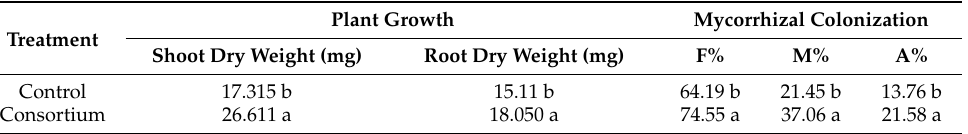
Table 1. Effect of bacterial inoculation on plant growth and mycorrhizal colonization (mycorrhizal frequency (F%), mycorrhizal intensity (M%) and richness of arbuscules (A%)) of M. sativa roots under NaCl stress. Values with different letters are significantly different ( p = 0.05). Means that do not share a letter are significantly